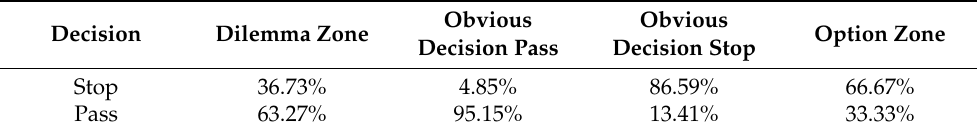
Table 4. Driver’s decision based on their relative